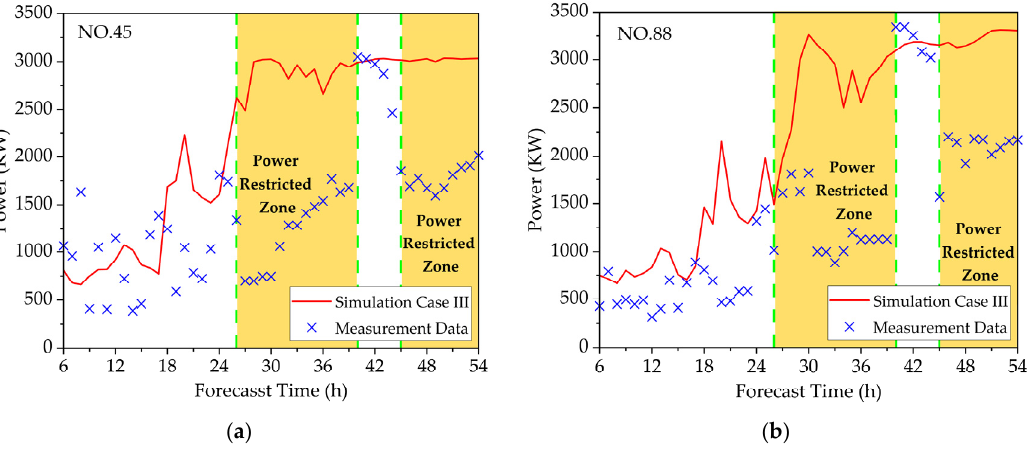
Figure 8. The simulation results from Case III and measurement data of power production for the selected wind turbines: ( a ) NO.45 turbine; ( b ) NO.88 turbine.